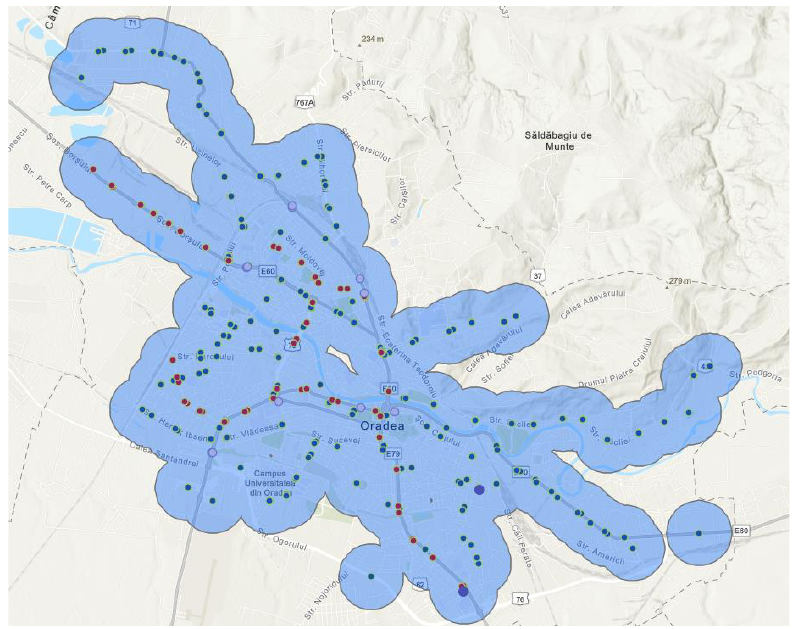
Figure 2. Buffer